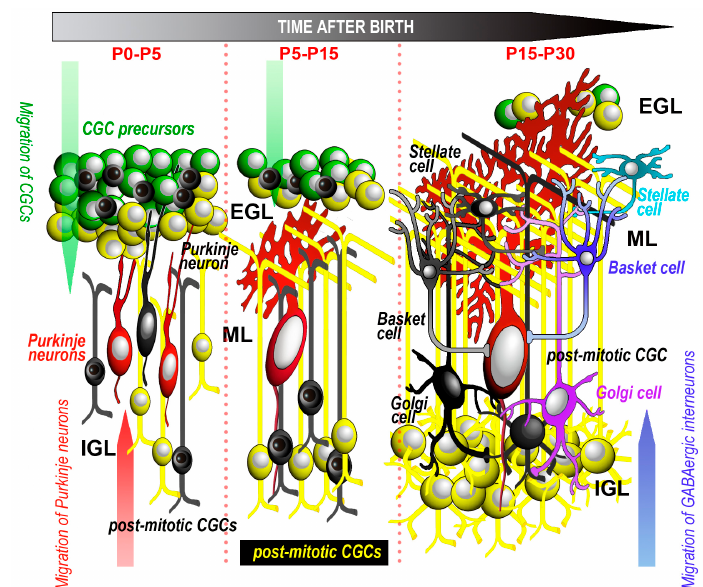
Figure 2. Schematic drawing of the main events related to cell proliferation, migration and apoptosis of cerebellar cortical neurons. Dead neurons are black. For simplicity, glial cells are not represented. Timetable refers to rodents and rabbits. See text for further explanations. Abbreviations: CGC = cerebellar granule cells; EGL = external granular layer; IGL = internal granular layer; ML = molecular layer; P = postnatal day.